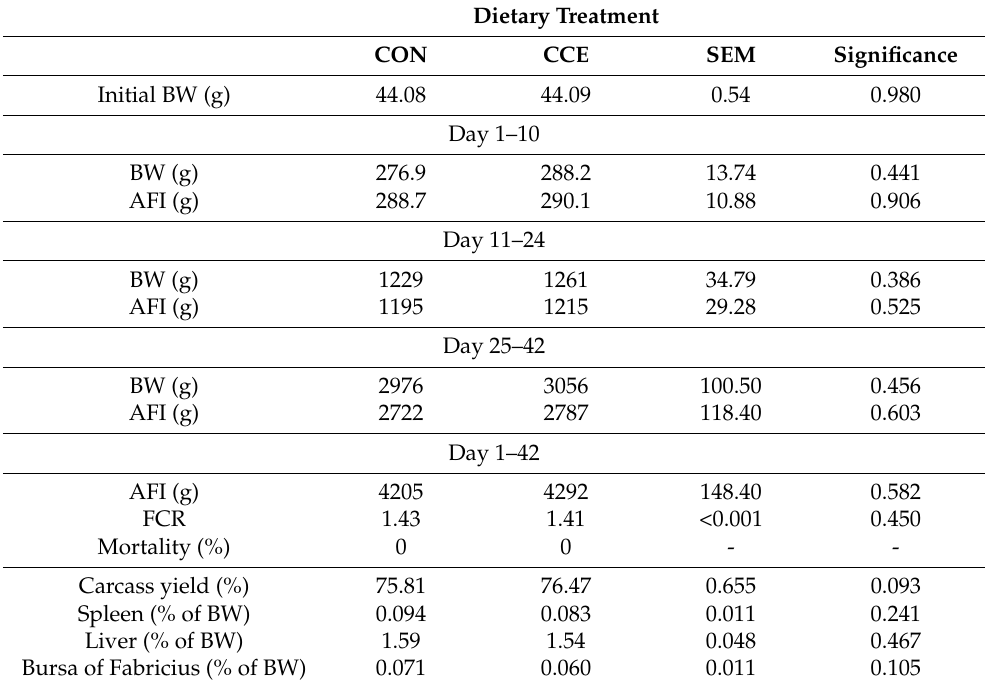
Table 6. Broiler growth performance on starter, grower, finisher, and overall experimental period among the two dietary treatments (Control; CON and carotenoid extract from Citrus reticulata included in soluble starch; CCE).